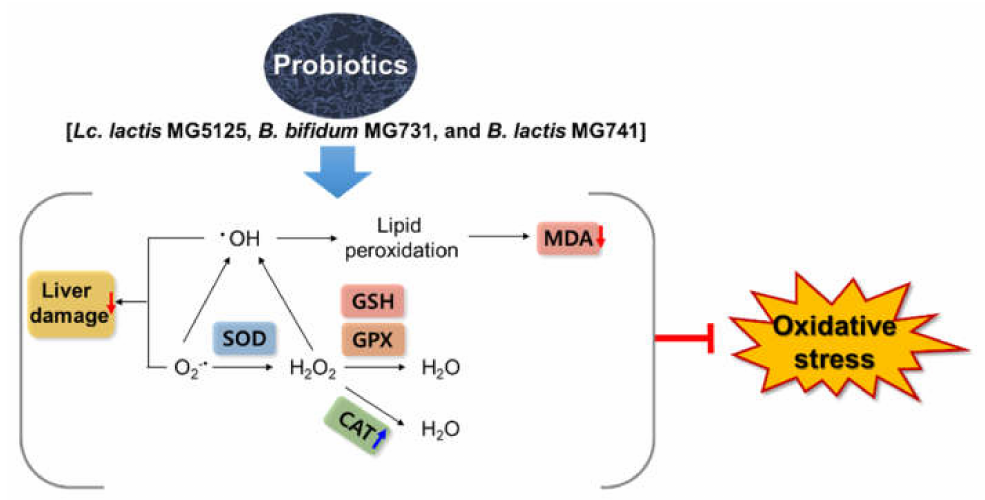
Figure 5. Probiotics exert a hepatoprotective effect by preventing oxidative stress in HepG2 cells and t -BHP-induced